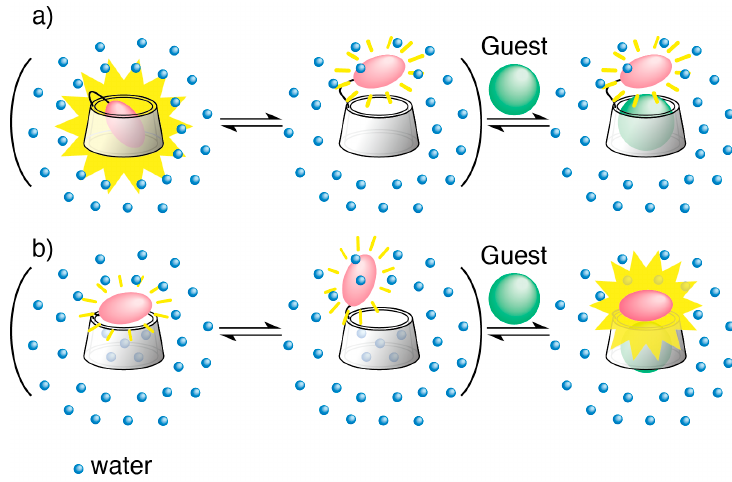
Figure 1. Turn-off and turn-on chemosensors: ( a ) An equilibrium model for guest-induced conformational change in a conventional chromophore-modified cyclodextrin (turn-off CD chemosensor) in aqueous solution; ( b ) An equilibrium model for guest-induced conformational change in a new type of chromophore-modified cyclodextrin (turn-on CD chemosensor) in aqueous solution.